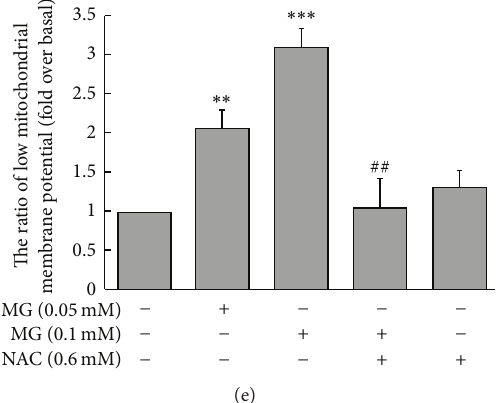
Figure 3: Effects of MG on the production of ROS in MIN6/INS-1 cells and MMP in MIN6 cells. ((a), (b), and (c)) ROS production was significantly increased by MG, as detected by fluorescence microscope ((a) for MIN6; 100x) and flow cytometer ((b) for MIN6; (c) for INS- 1). ((d) and (e) for MIN6) Incubation with MG for 3h increased the rate of low MMP (the bottom right gate). This illustrated that MG significantly decreased MMP. The effects of MG on MIN6 were reversed by coincubation with NAC. ∗ 𝑝 < 0.05 , ∗∗ 𝑝 < 0.01 , and ∗∗∗ 𝑝 < 0.001 compared to control group (0mM MG + 0 mM NAC). # 𝑝 < 0.05 , ## 𝑝 < 0.01 compared to the higher MG group (0.1mM MG + 0 mM NAC).